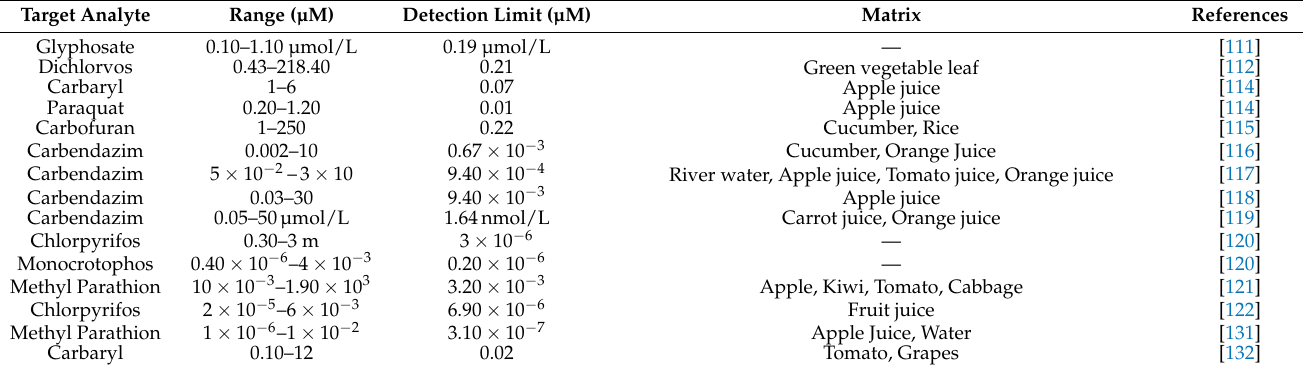
Table 2. Numerous 2D materials based electrochemical sensors for the detection of